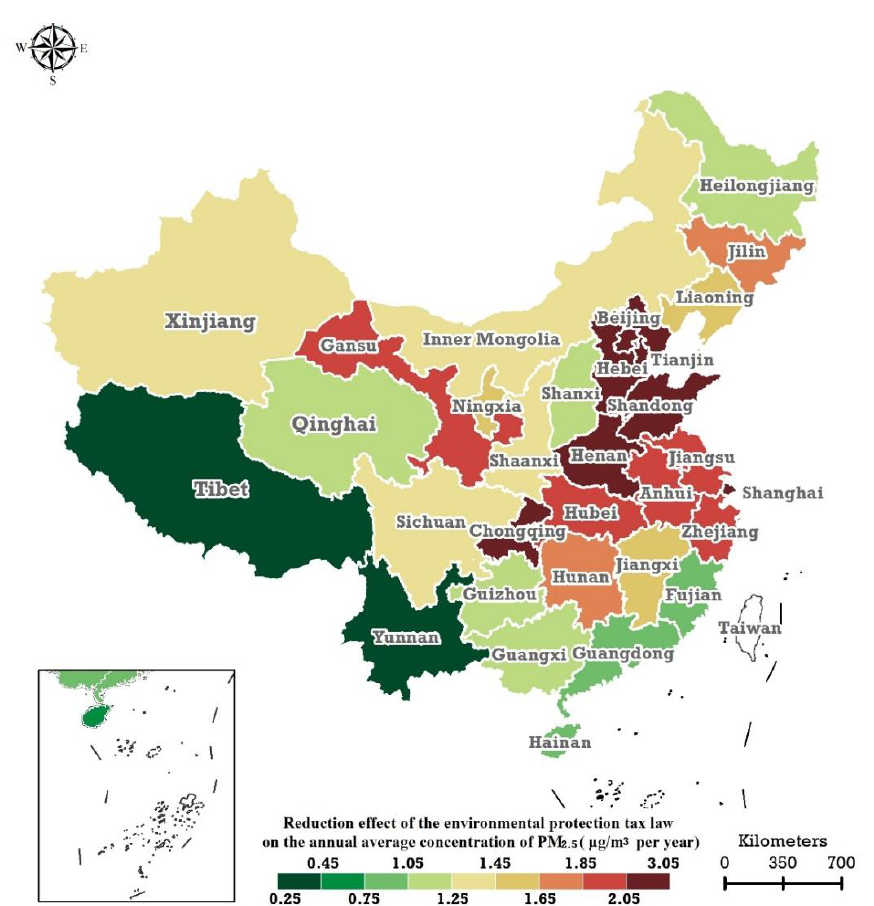
Figure 1. Spatial distribution of the abatement effects of the Environmental Protection Tax Law on the in-situ monitored PM 2.5 annual concentrations of the 31 provincial regions of the Chinese mainland in 2018 – 2019.